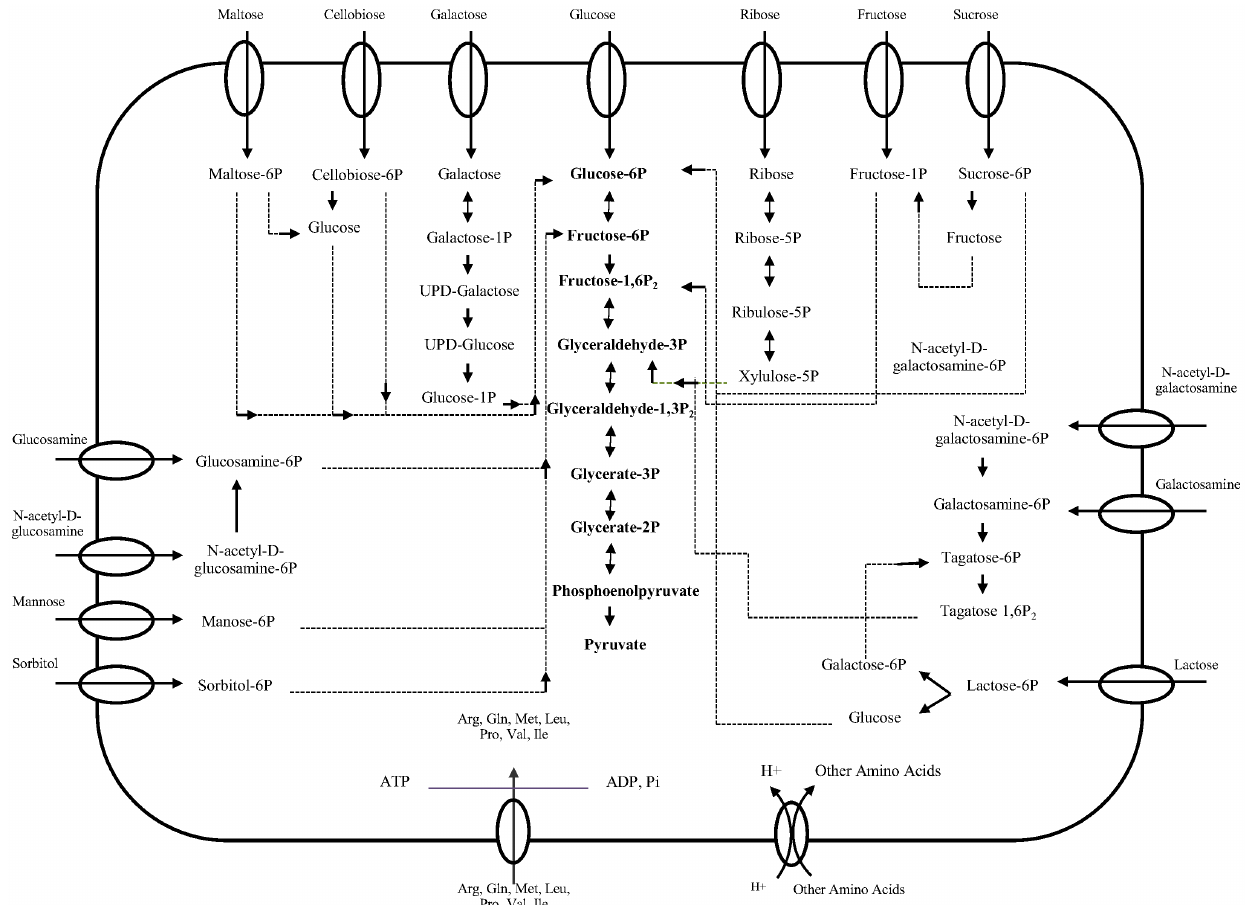
Figure 2. Metabolic map of carbohydrate metabolism of L.casei 12A and ATCC 334. Glycolytic metabolites are listed in bold.